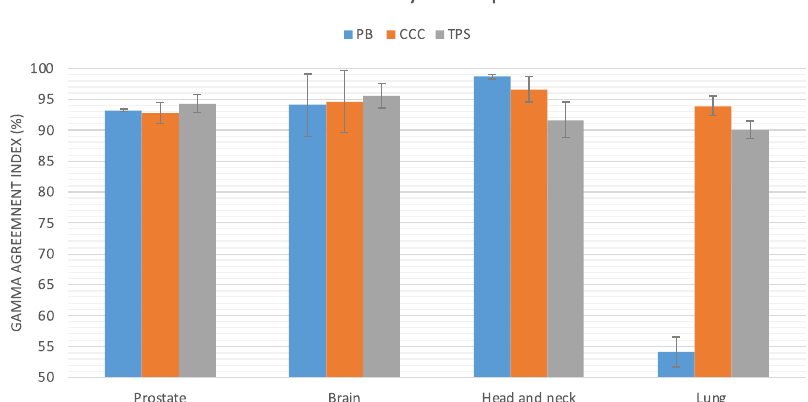
Figure 5. Gamma agreement index at 3%/3 mm local normalization with 10% dose threshold between film dosimetry at the central axial slice, the two Dosimetry Check algorithms, pencils beam (PB) and Collapsed Cone Convolution (CCC), and the planned dose distributions computed by the treatment planning system (TPS).